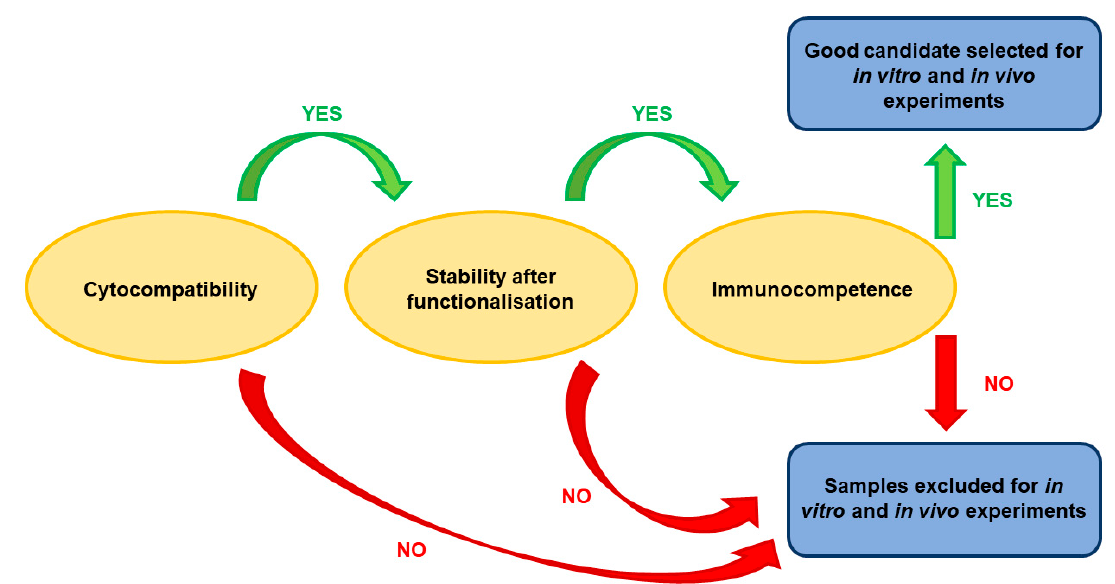
Figure 1. Strategy for the selection of the best nanoparticle for in vitro and in vivo experiments.